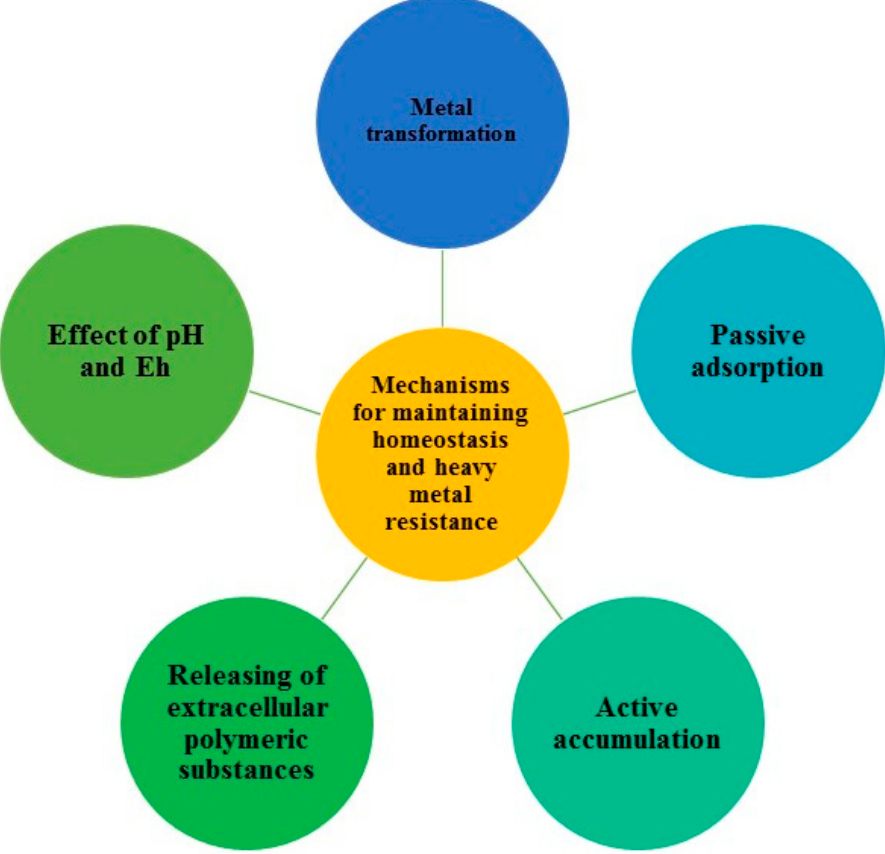
Figure 1. Microbial mechanisms responsible for maintaining homeostasis and heavy metal resistance.